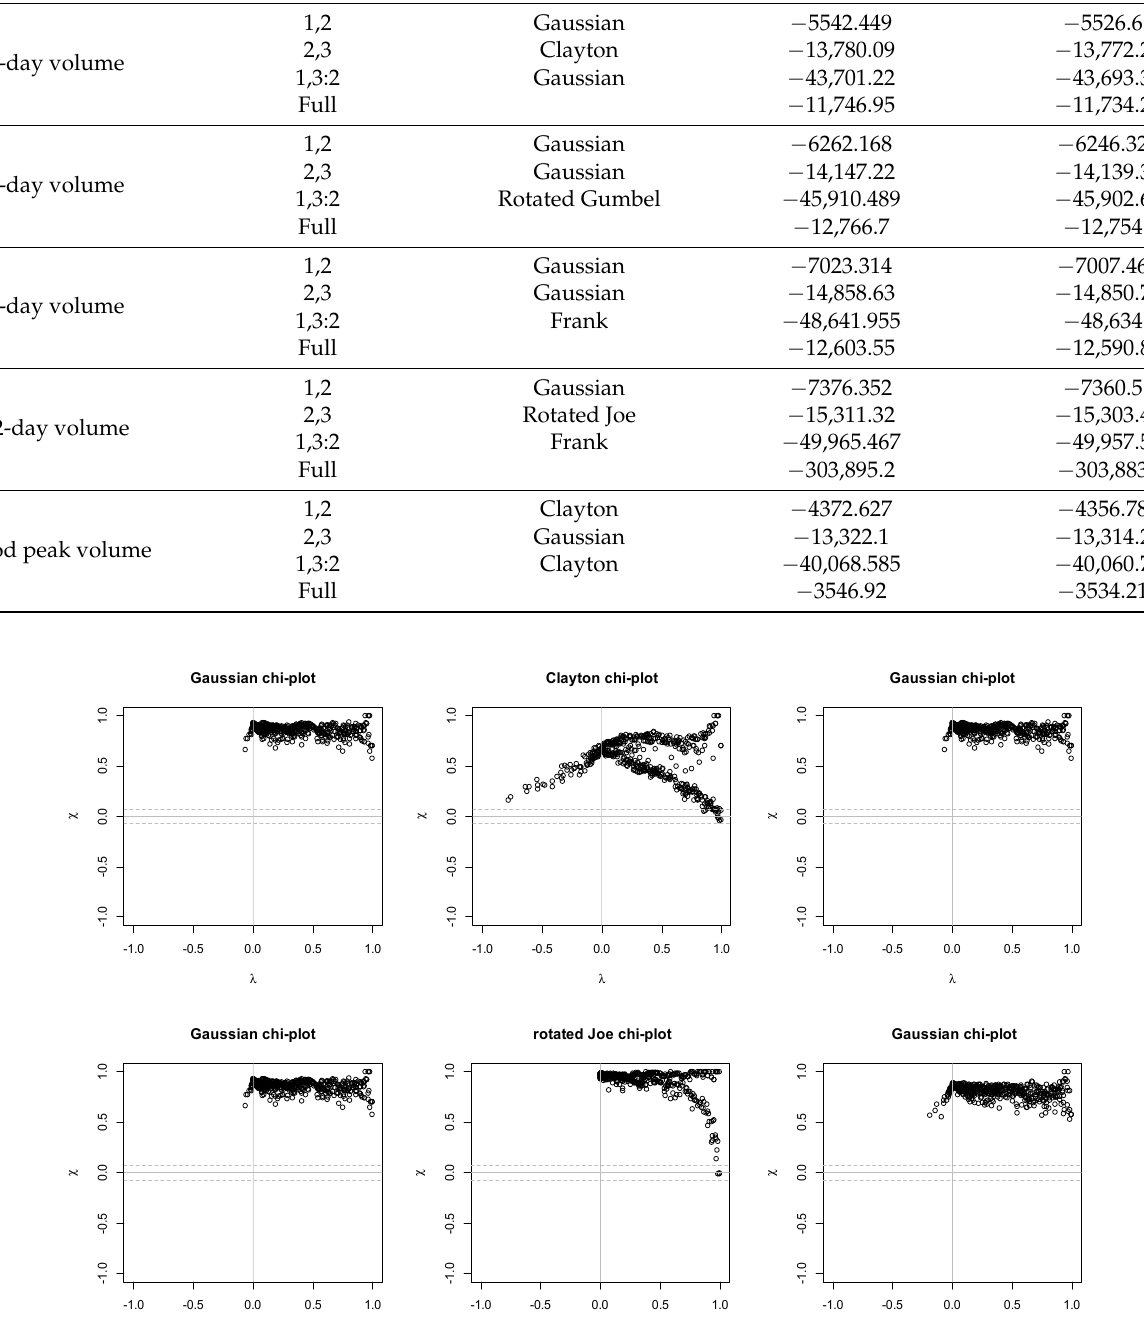
Figure 7. Chi-plots of pair flood volume variables of Xianyang and Huaxian County.